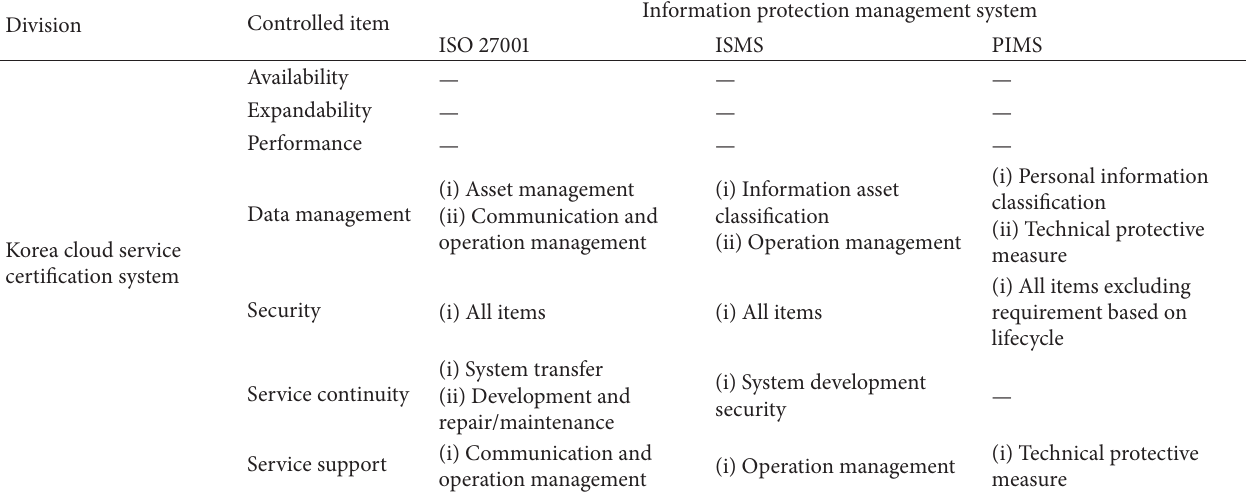
Table 15: Comparison of security among Korea cloud service certification system, ISO 27001, ISMS, and PIMS.